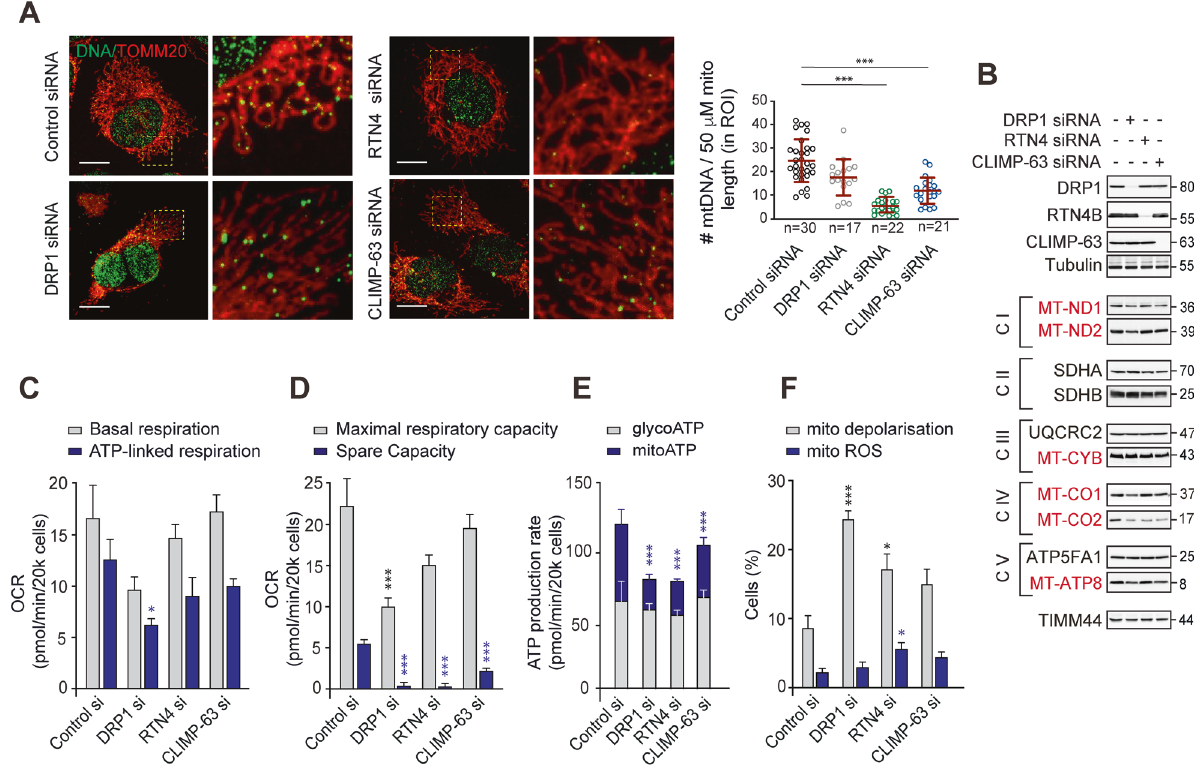
Fig. 5 Loss of DRP1 or ER shaping proteins, RTN4 or CLIMP-63, decreases mtDNA foci, mtDNA-encoded proteins and alters different facets of mitochondrial respiration. A H1299 cells, transfected with control, DRP1, RTN4 or CLIMP-63 siRNA for 72 h, were fi xed and immunostained against DNA (green) and TOMM20 (red). Areas demarcated by the dashed yellow boxes are magni fi ed in the right panel of each condition. Scale bars are 10 μ m. The number of mtDNA foci and mitochondrial length per ROI were calculated using ImageJ and plotted in the graph on the right. Data in are presented as mean ± SD; each dot represents one ROI within one cell, the numbers ( n ) of which (taken across three independent experiments) are indicated below the x -axis. *** p < 0.001 (Kruskal-Wallis test, with Dunn ’ s multiple comparisons test). B Whole cell lysates of H1299, transfected as in A , were immunoblotted against the indicated antibodies. mtDNA-encoded proteins are highlighted in red. C – E Seahorse XF-96 analysis of mitochondrial respiration in H1299 cells treated with the indicated siRNAs for 72 h prior to analysis. Histograms display quantitation of ( C ) basal versus ATP-linked respiration, ( D) maximal versus spare respiratory capacity, and ( E ) the proportion of ATP generated from mitochondrial oxidative phosphorylation (mitoATP) versus that produced by glycolysis (glycoATP), both calculated using the Real-Time ATP Rate Assay. F Histograms display the extent of mitochondrial depolarisation and reactive oxygen species (ROS) generation in H1299 cells, transfected as in A . Data in C – E are presented as mean ± SEM, from at least 5 independent experiments. * p ⩽ 0.05, ** p ⩽ 0.005, *** p ⩽ 0.001 (all ordinary one-way ANOVAs with Dunnett ’ s multiple comparisons tests: C , basal F(350) = 18.27, p < 0.0001; ATP-linked F(350) = 18.10, p < 0.0001; D, maximal F(340) = 23.19, p < 0.0001; spare F(337) = 15.39, p < 0.0001; E, mitoATP F(316) = 35.54, p